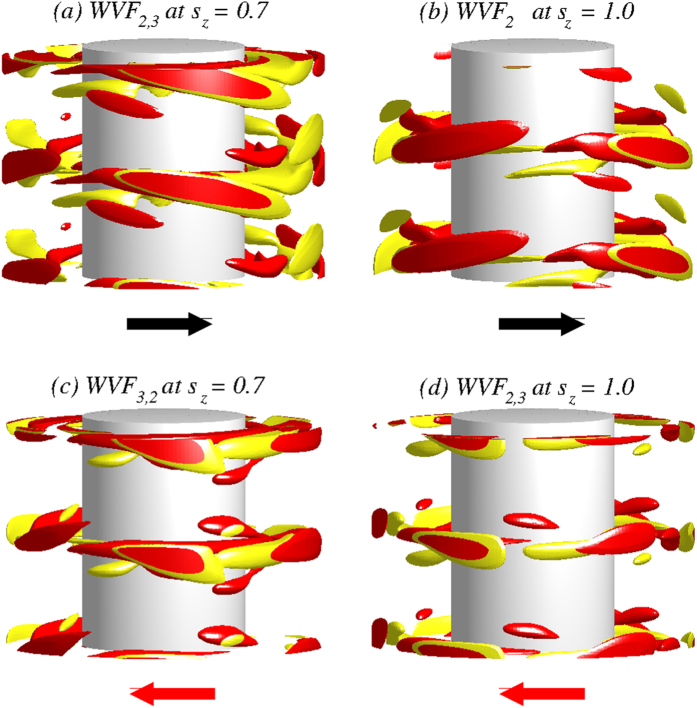
Structural properties of flows in the presence of an axial magnetic field.Isosurfaces of  for WVF2,3, WVF3,2 and WVF2 for  and . Vorticity isosurfaces are for , and two periods of motion are plotted in the axial direction. The arrows below the snapshots illustrate the rotational direction, which appears laterally on the cylinders. For these values of  the flow pattern of WVF2,3 is pro-grade but that of WVF3,2 is retrograde. See also movie files movie3.avi and movie4.avi in SMs.